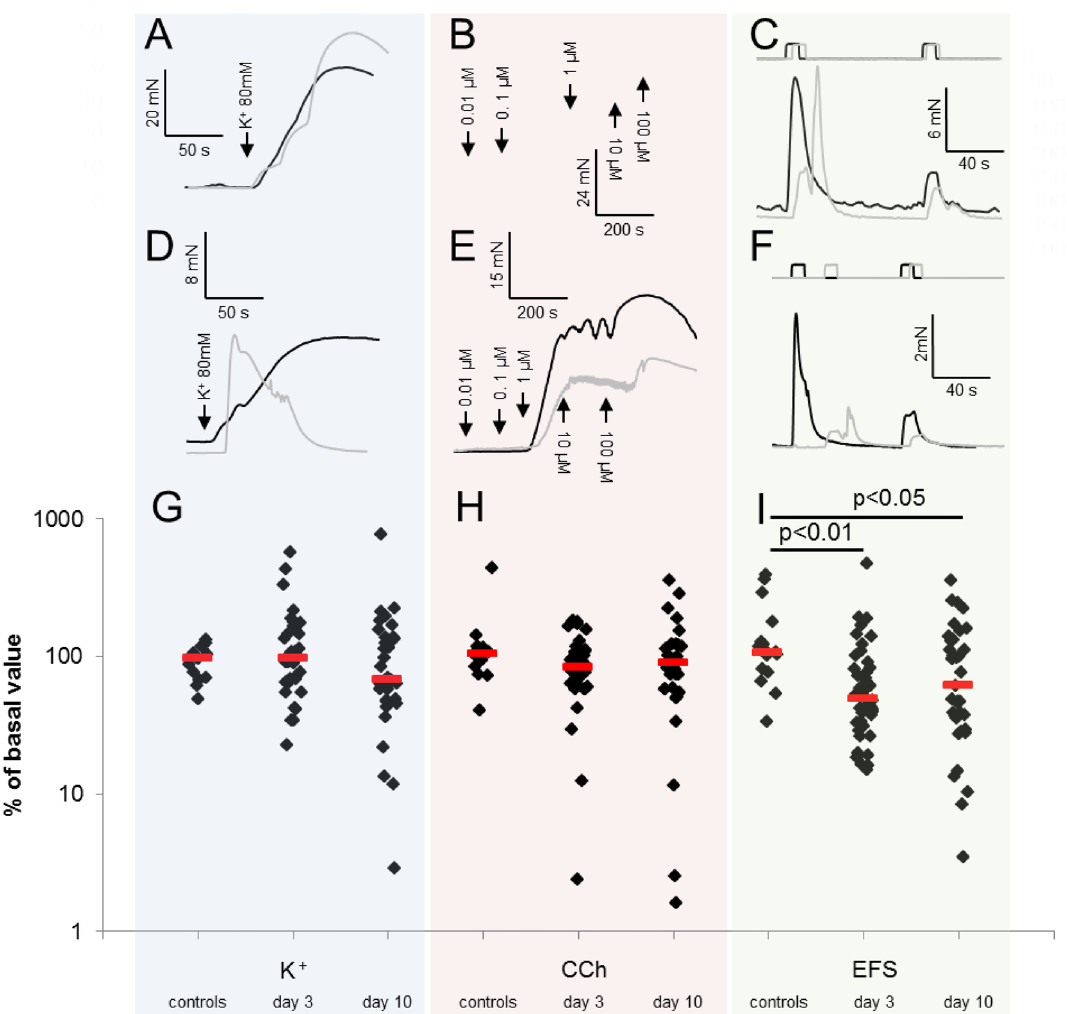
Figure 3. Contractile responses to high-K + , CCh and EFS before and after 3-h of incubation with human serum. Black traces: response prior to serum incubation; grey traces: response at the end of three hours serum incubation. Between the subsequent EFS depicted in ( C ), 1 µM TTX was applied. ( A – C ) representative original traces from strips incubated with serum obtained from a healthy control subject; ( D – E ) traces from strips incubated with patient serum obtained at day 3 of critical illness. Applied stimuli were high-K + ( A , D ), CCh ( B , E ) and EFS ( C , F ); ( G – I ) data and median values of contractions evoked from strips incubated either with serum from healthy controls or with serum obtained from patients at day 3 or at day 10 of their critical illness; stimulations were high-K + ( G ), maximum concentration of CCh-staircase ( H ) and EFS ( I ). Numbers over horizontal lines in ( I ) designate significance of differences as calculated by one-way ANOVA with Dunn’s post- EFS-responses displayed in Fig. 3C and F. In those strips incubated with serum from healthy controls, the ampli- tudes of responses to all types of stimuli did not change significantly over time. In strips incubated with patient serum obtained at day 3 and day 10 of disease, responses to EFS decreased significantly. When serum from healthy controls was used instead, no change in EFS could be detected (Fig. 3I). As in the case of K + and CCh, the EFS-response amplitude after serum incubation was divided by that seen before serum incubation. The ratios obtained by this procedure, given here as %-values, were then compared according to the different source of sera. (The resulting median ratios were: 106% for serum from healthy controls; 49% for serum obtained at day 3 and 62% for serum obtained on day 10 of illness. One-way-ANOVA on ranks detected a difference between the three serum-groups (p = 0.003). Dunn’s groupwise comparison confirmed differences between the effects of serum from healthy controls and that obtained at day 3 (p < 0.01) and day 10 (p < 0.05), but there was no difference between effects of sera obtained at day 3 and 10 when compared with each other. Responses to high-K + and CCh were compared analogously and did not change significantly over time in strips exposed to patient serum, neither regarding the amplitude of responses (Fig. 3G,H) nor the concentration- dependency (CCh EC 50 after serum incubation, median (IQR): healthy control serum: 1.4 (0.7–3.8) µM; patient serum, day 3: 1.7 (0.8–6.8) µM; patient serum, day 10: 1.5 (0.7–22) µM, One-Way ANOVA: p = 0.44).